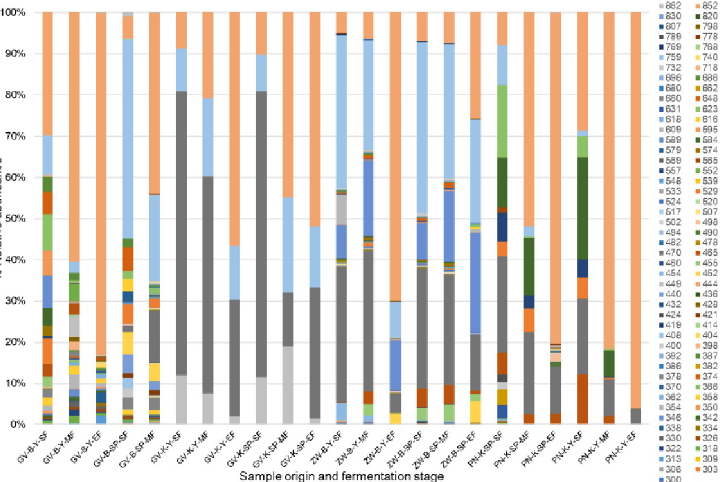
Fig 2. Population dynamics showing fungal OTU development. Start (SF), middle (MF) and end (EF) of fermentation. Zweigelt from Burgenland (ZW-B), Gru¨ner Veltliner from Burgenland and Klosterneuburg (GV-B and GV-K), Pinot not from Klosterneuburg (PN-K). the samples GV-B-SP-EF are missing because the fermentation has